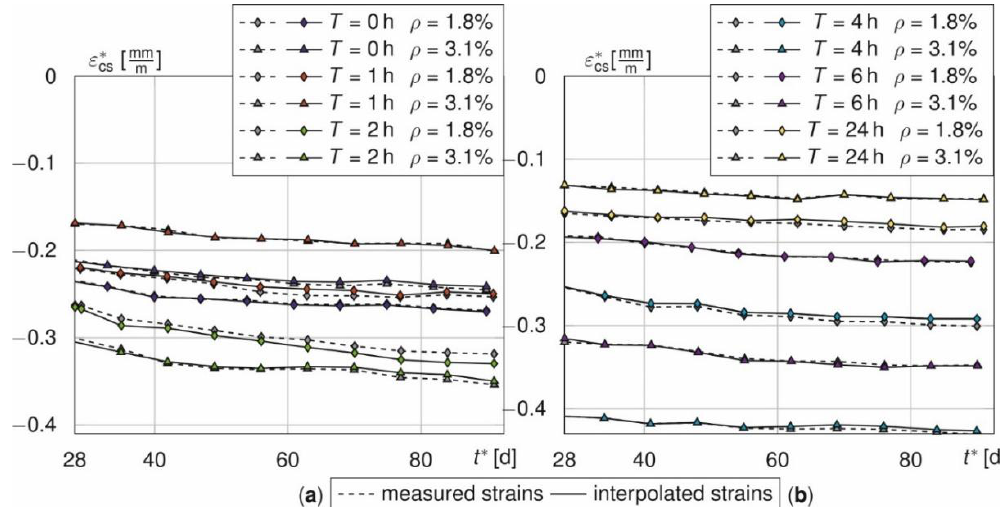
Figure 11. Comparison of the interpolated (colours) and measured (grey, dashed) total strains of the beams for T = 0, 1, 2 h ( a ) and T = 4, 6, 24 h ( b ).